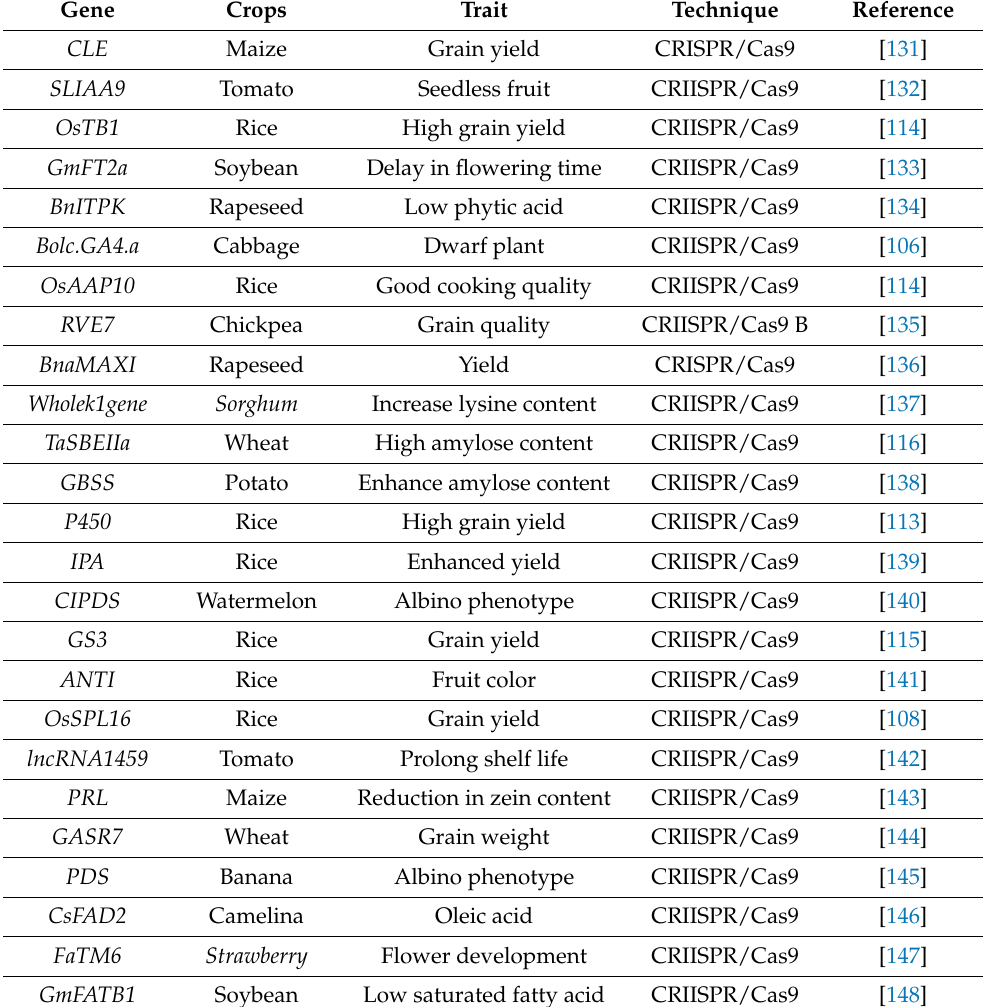
Table 4. Uses of CRISPR/Cas9 for quality and yield enhancement in crops. Gene Crops